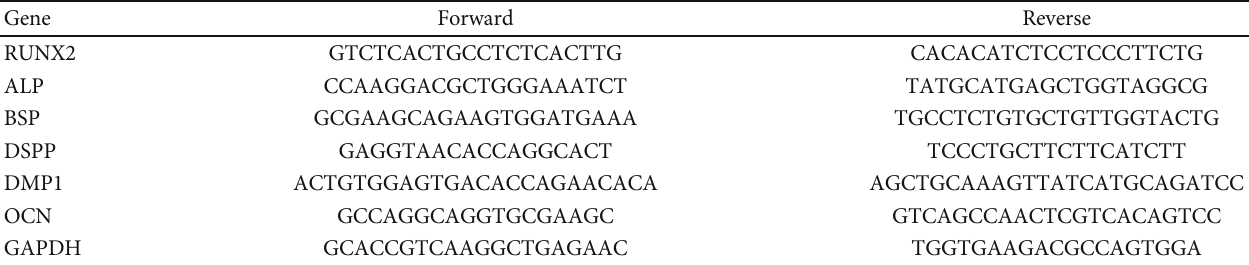
Table 1: Primers sequence for real-time